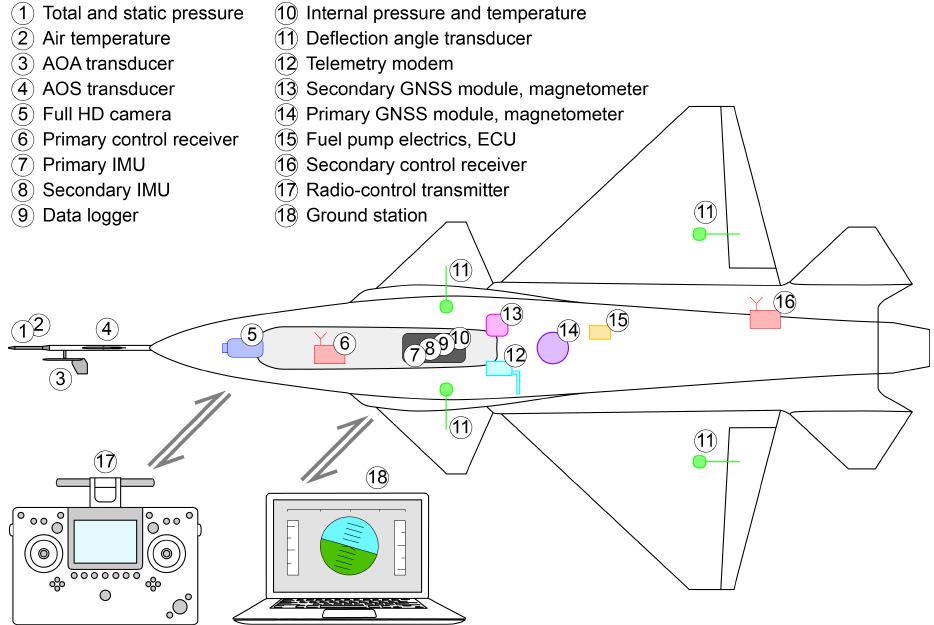
Figure 10. Example of a low-cost, customised data acquisition system based initially on a commer- cially available open-source autopilot: Layout of the main components and radio links currently implemented on the GFF demonstrator.